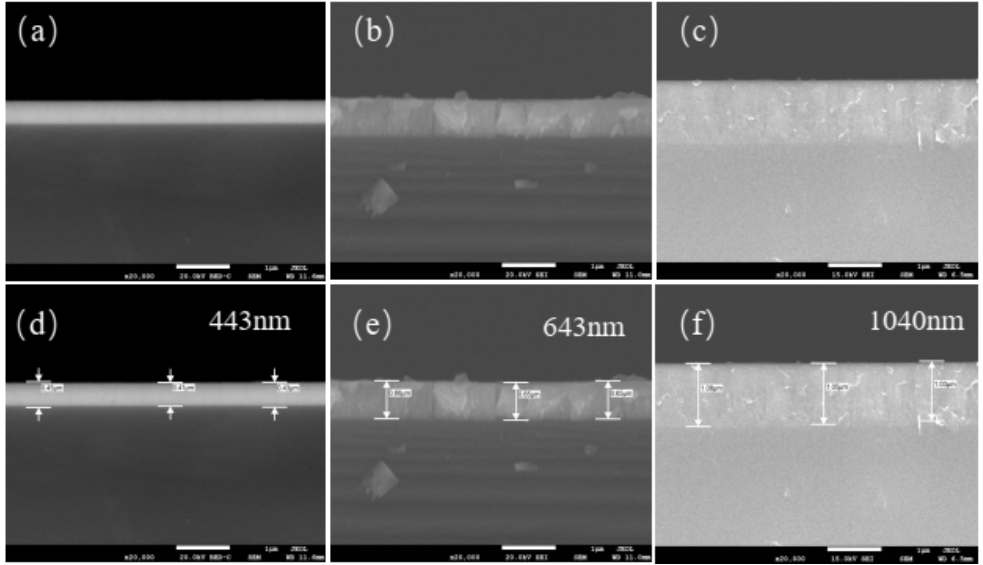
Figure 1. Side view of different thickness LaF 3 layers. ( a ) and ( d ) 443 nm, ( b ) and ( e ) 643 nm, ( c ) and ( f ) 1040 nm.